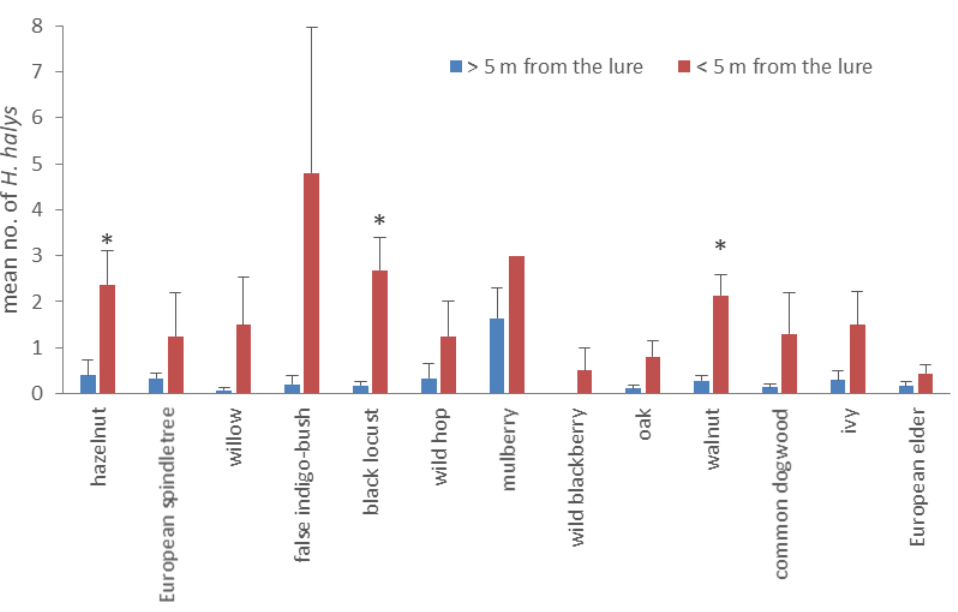
Figure 3. Mean numbers (±SE) of Halyomorpha halys adults per plant, sampled on same species located either in the proximity (5 m) of the pheromone lure or farther (> 5 m) from it. * indicates that significant differences in mean number of H. halys were recorded for that plant species (one-way ANOVA, p < 0.05).